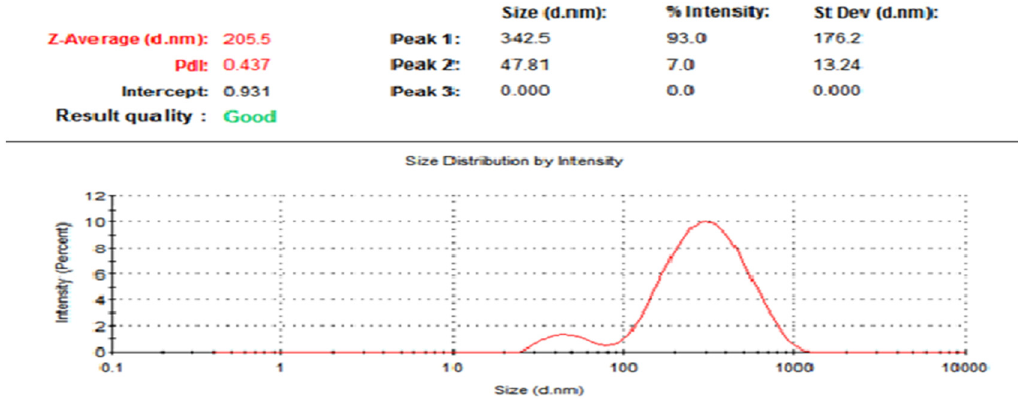
Figure 2: DLS spectrum of mustard seed